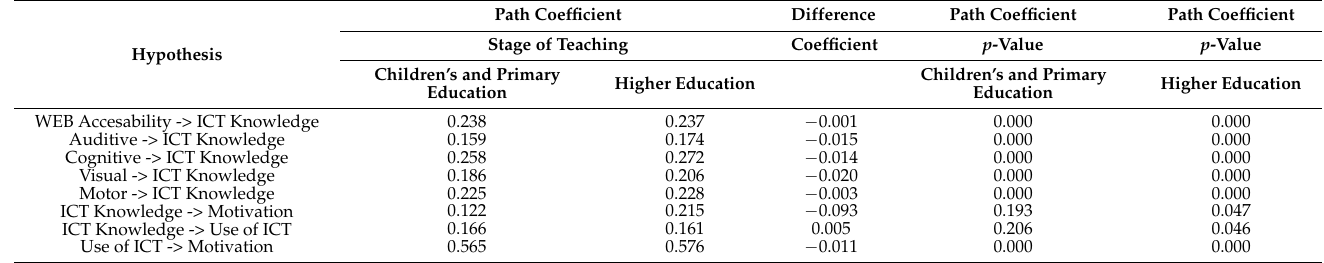
Table 5. Multi-group